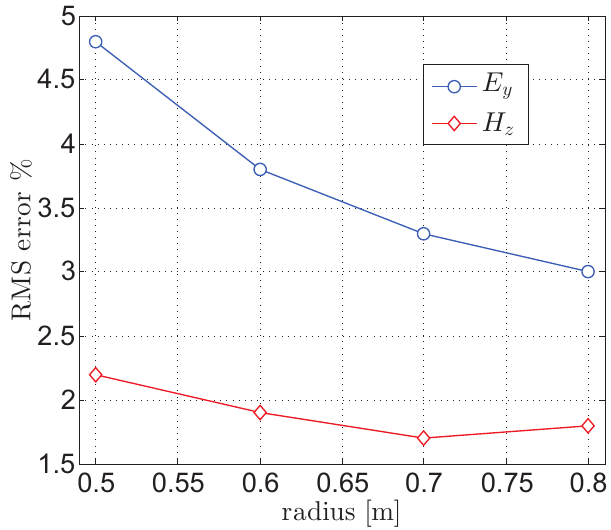
Figure 12. Root-mean-square (RMS) errors for H z and E y with different observation